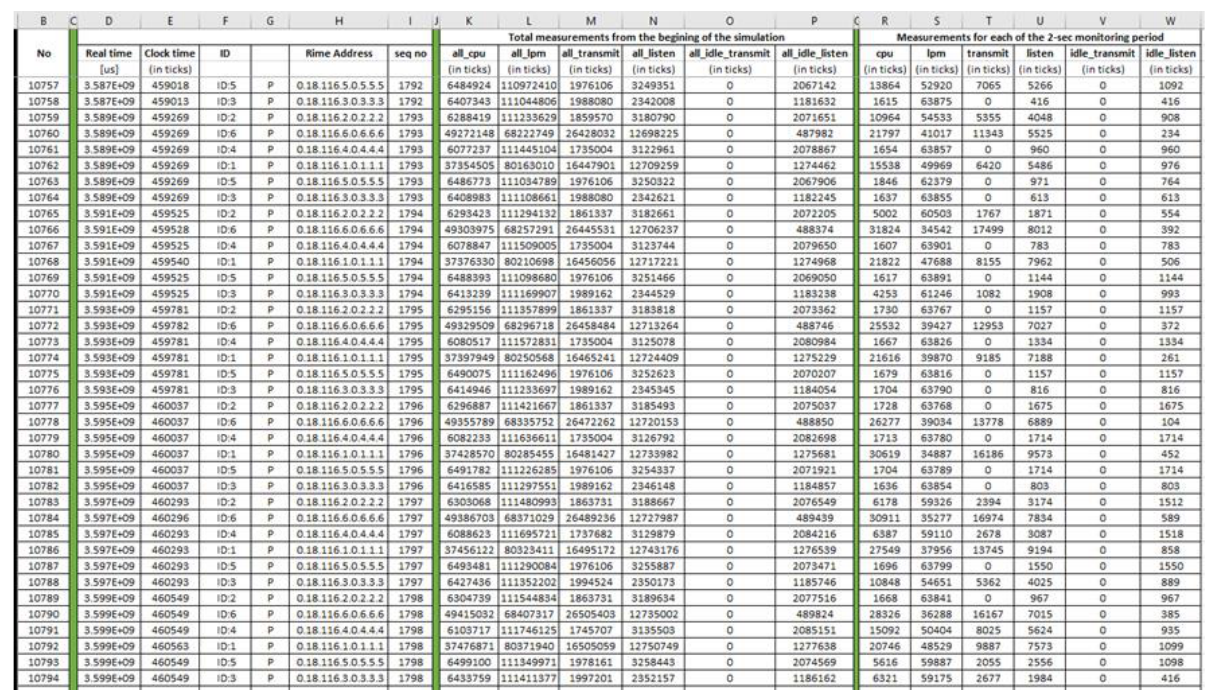
Figure 29. Malicious “pwrtrace.csv”— 10,757 to 10,794 records.